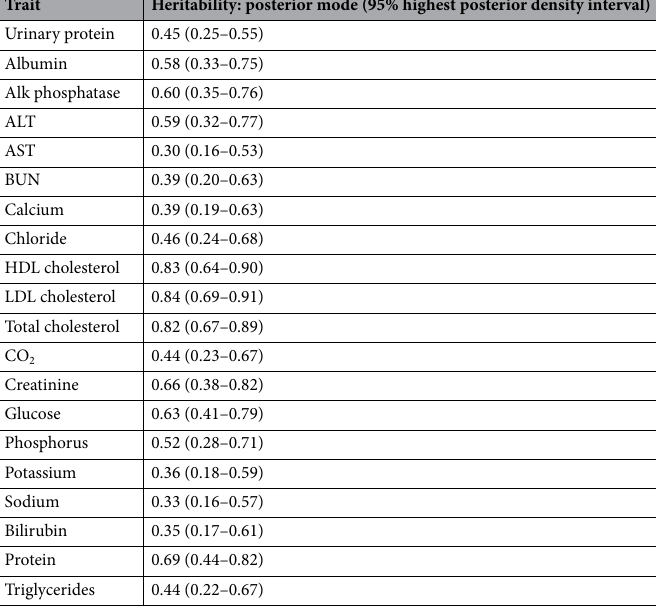
Table 1. Narrow sense heritability for urinary protein and serum biochemistries.